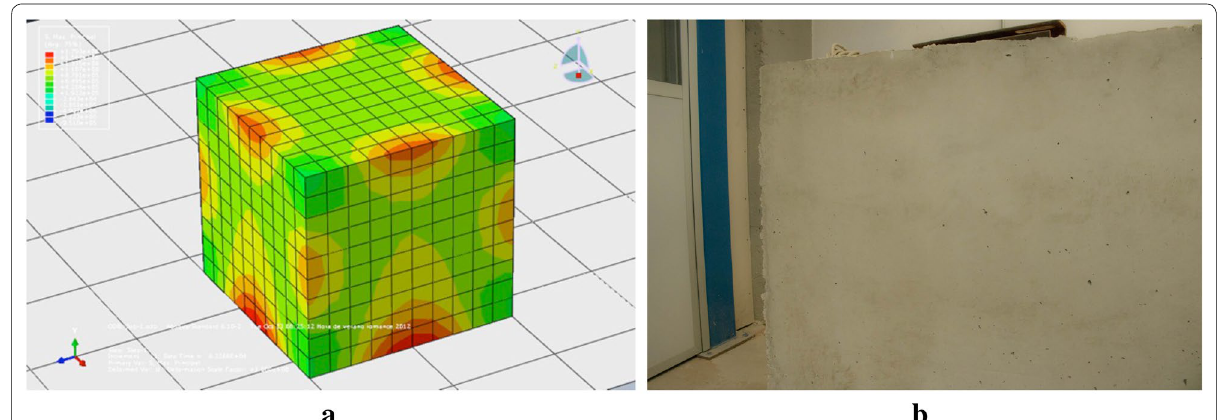
Fig. 12 a Maximum principal stress distribution (MPa) within the concrete cube 12 h after the casting; and b state of the cube 28 days after the curing process with no evidences of early age